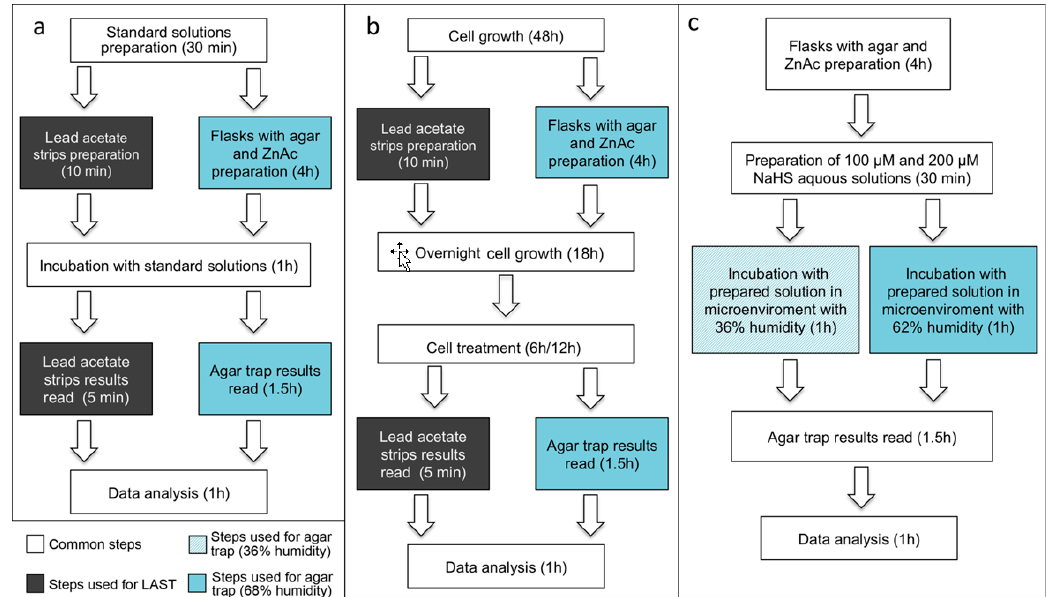
Figure 1. The scheme of experimental design for agar trap and LAST assays: ( a ) experimental design for standard curves; ( b ) scheme for experiments in cell culture; and ( c ) experimental design for detect levels of agar trap method precision in different microenvironmental conditions. ZnAc; zinc